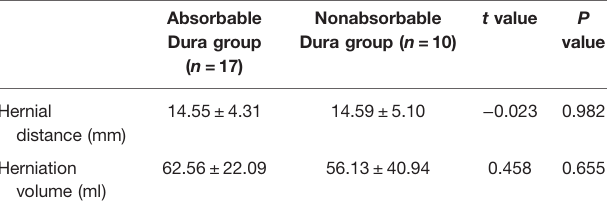
TABLE 3 | TCH severity comparison between absorbable dura group and nonabsorbable dura